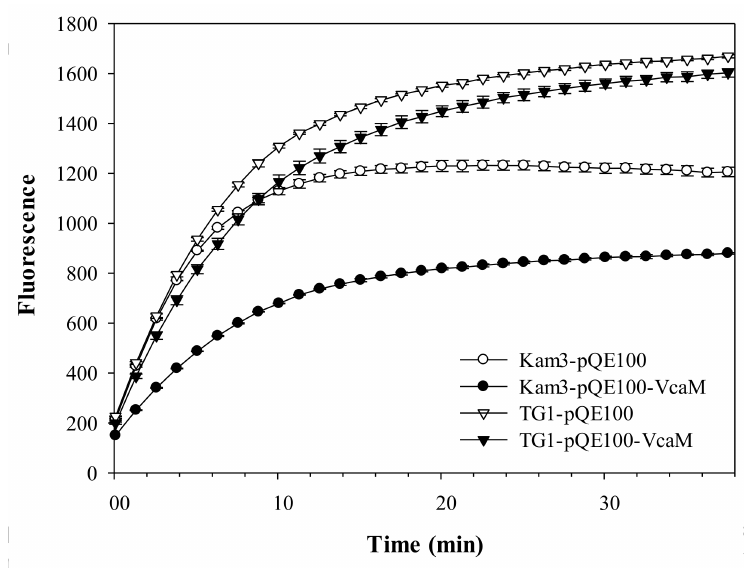
Figure 6. Drug accumulation of H33342 in drug sensitive strain E. coli Kam3 and TG1 overexpressing VcaM.